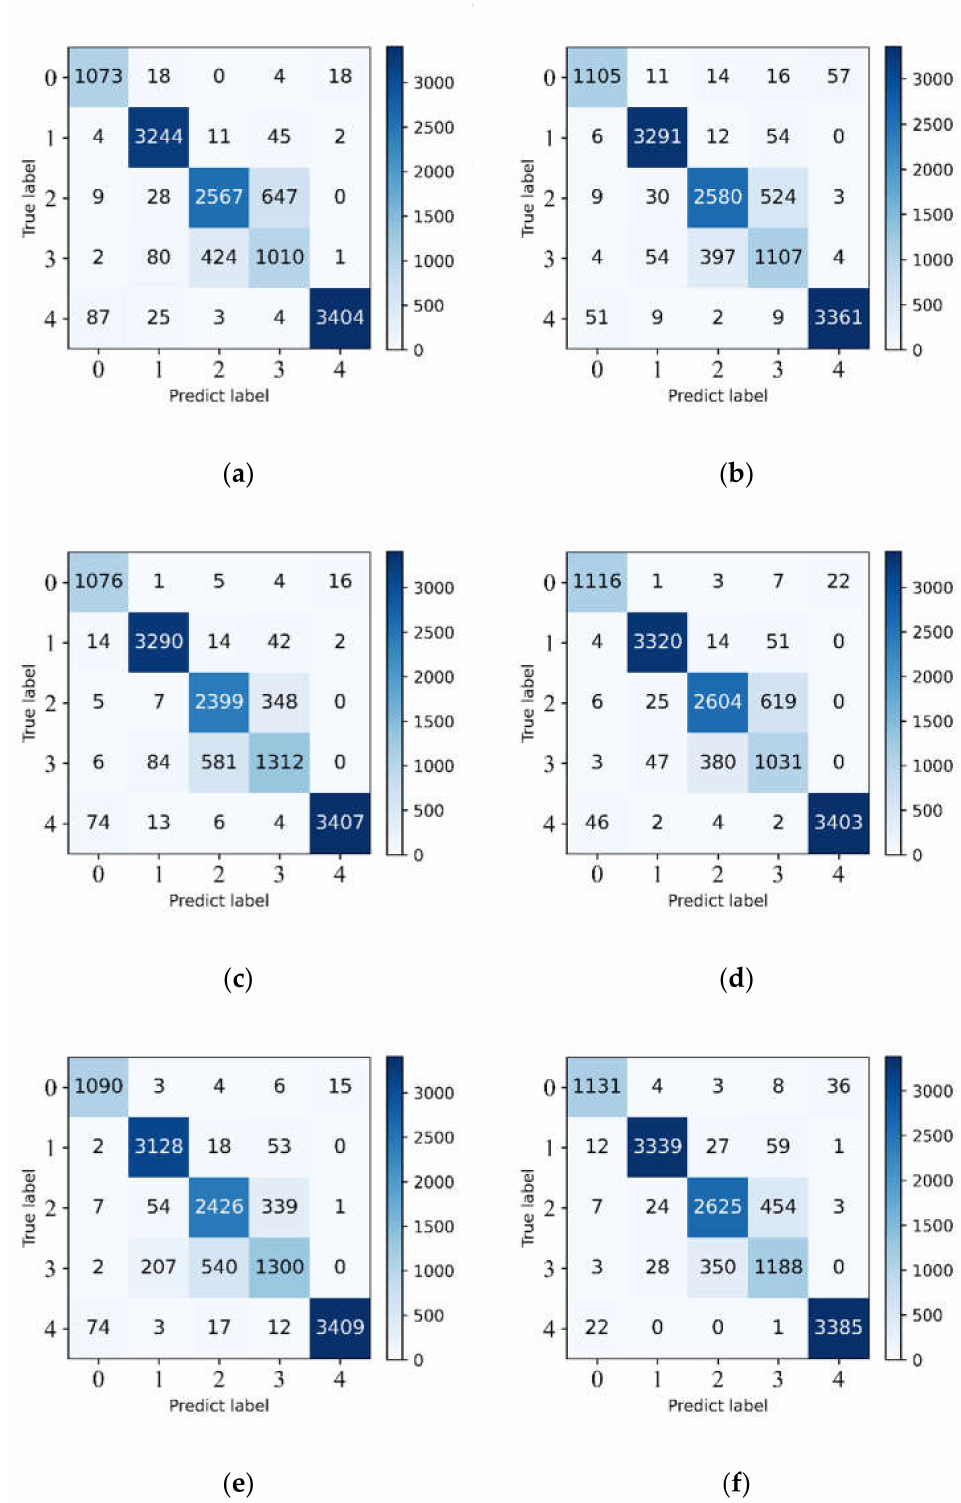
Figure 9. Overlapped confusion matrix of different algorithms: ( a ) VGG19; ( b ) Resnet50; ( c ) NAS- NetLarge; ( d ) Inceptionv3; ( e ) MobileNetV2; ( f ) RED-CNN. In the graph: 0 represents COVID-19, 1 represents normal, 2 represents bacterial pneumonia, 3 represents viral pneumonia, and 4 represents pulmonary